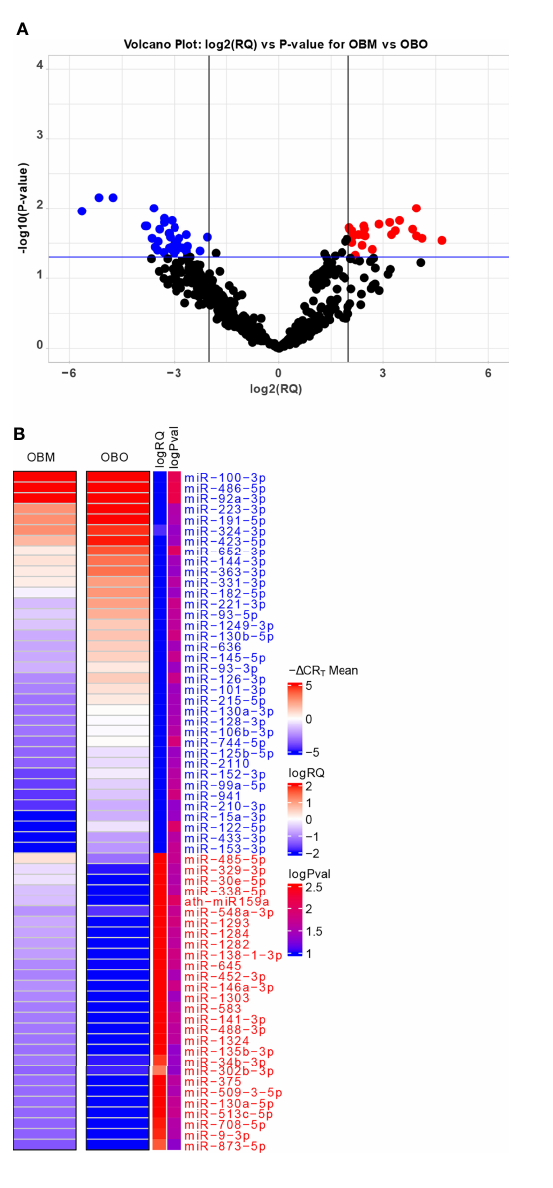
FIGURE 2 | (A) Volcano Plot highlighting the differentially expressed microRNAs. The red-colored microRNAs are over-expressed in OBM versus OBO while the blue-colored microRNAs are under-expressed. Here ‘ RQ ’ is equivalent to the fold-change of a particular miRNA (Wang, Wang, and Xi 2011) and is ∝ mean - D CR T values. (B) The mean - D CR T values for the differentially expressed miRNAs for the OBM and OBO groups respectively. The - D CR T values are ∝ to miRNA expression, where the higher - D CR T value (or CR T value) corresponds to higher miRNA expression levels. This is further re fl ected in the logRQ values which are equivalent to fold-change in the expression of individual miRNA. Here ‘ logPval ’ corresponds to -log10